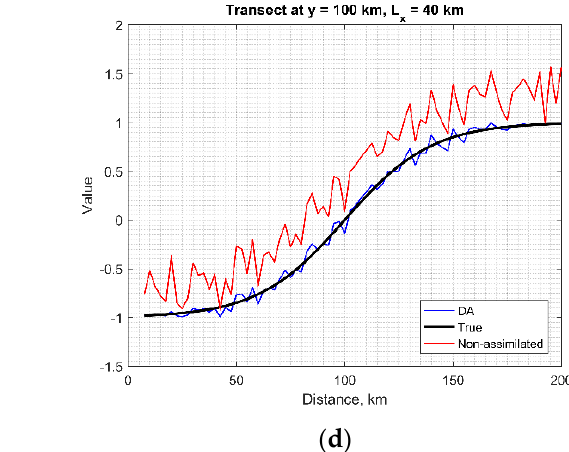
Figure 4. Results of NDA assimilation for fronts of different sharpness: ( a ) 𝐿 𝑥 = 10 km, ( b ) 𝐿 𝑥 = 20 km, ( c ) 𝐿 𝑥 = 30 km, ( d ) 𝐿 𝑥 = 40 km. The curves present data for the true field (black), non-assimilated noisy child model (red) and child model after NDA assimilation (blue).